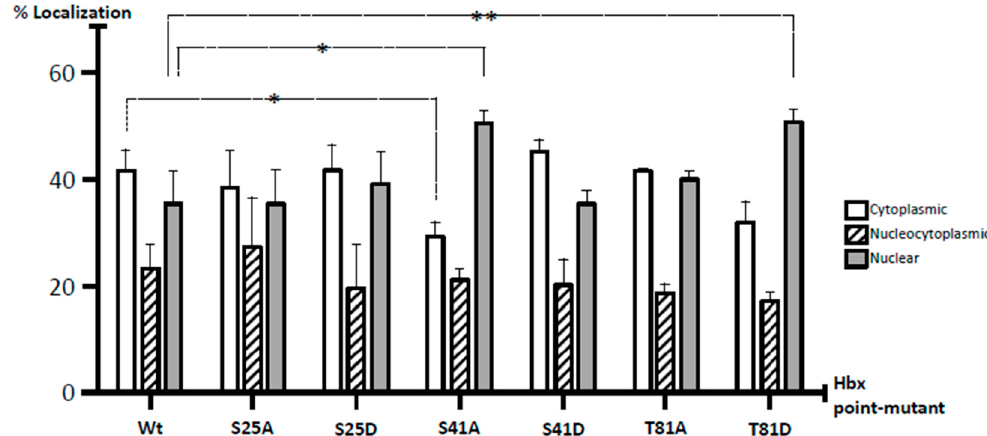
Figure 5. Subcellular distribution of the WT HBx-GFP and HBx-GFP point mutants. The standard deviation was obtained from three independent experiments. * p < 0.05, ** p < 0.01.